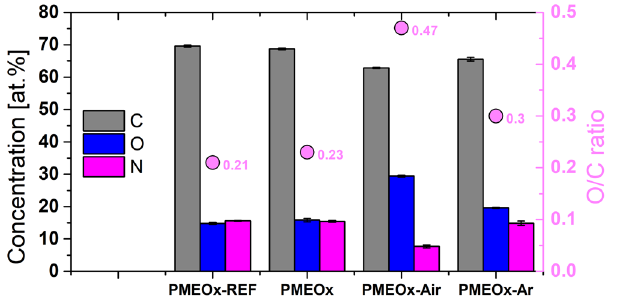
Figure 4. Atomic concentration of PMEOx coatings achieved in different plasma treated conditions measured by XPS. Comparison of atomic concentration (%) of C, O, N in PMEOx coating before (sample PMEOx) and after plasma treatment (samples PMEOx-Air, PMEOx-Ar) with PMEOx-REF. Before washing